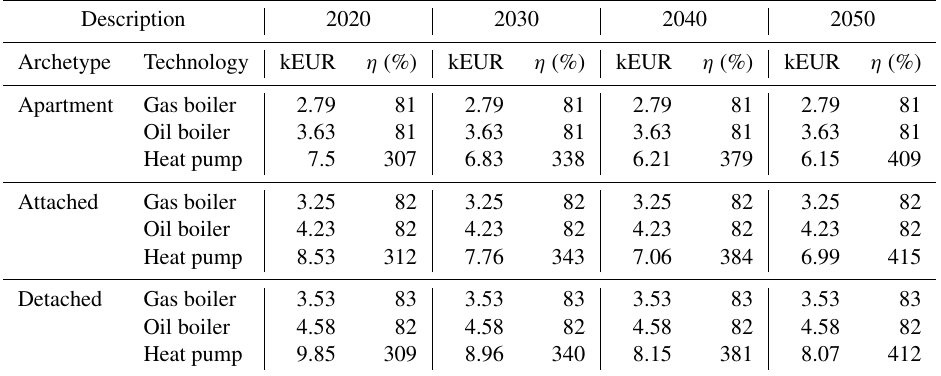
kEUR: thousand euro.